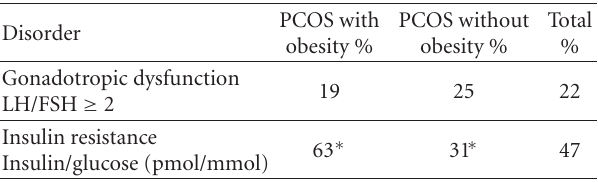
Table 4: Frequency of pathophysiologic components of polycystic ovary syndrome